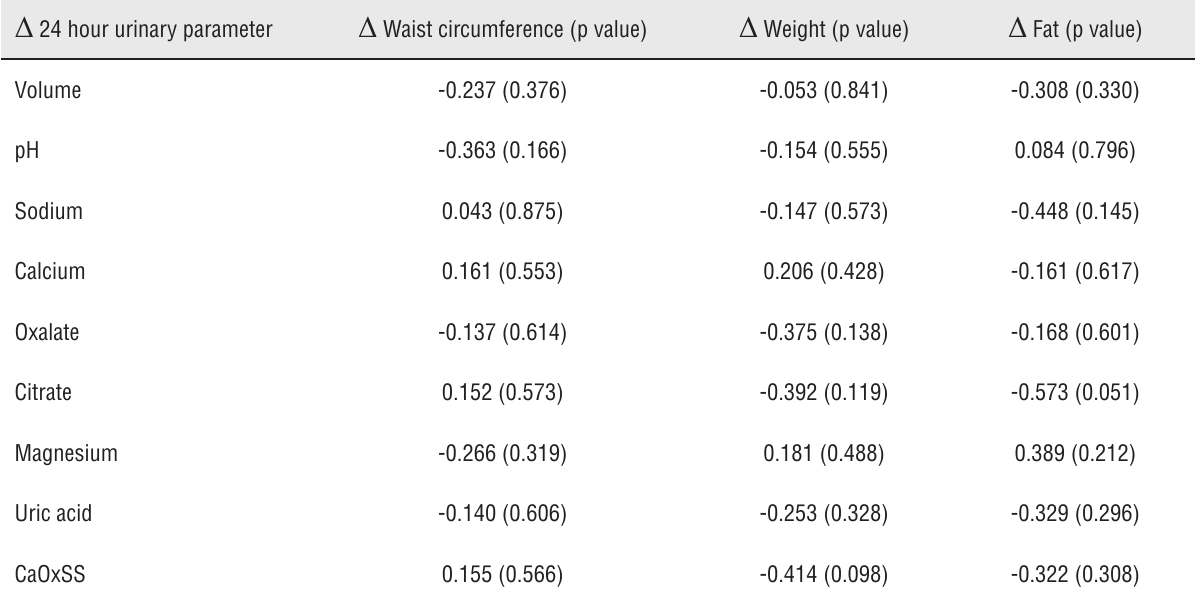
Supplementary Table 2 - Correlation between 24-hour urinary parameters change and weight change, abdominal circumference change and fat mass change in 17 patients with calcium oxalate dihydrated